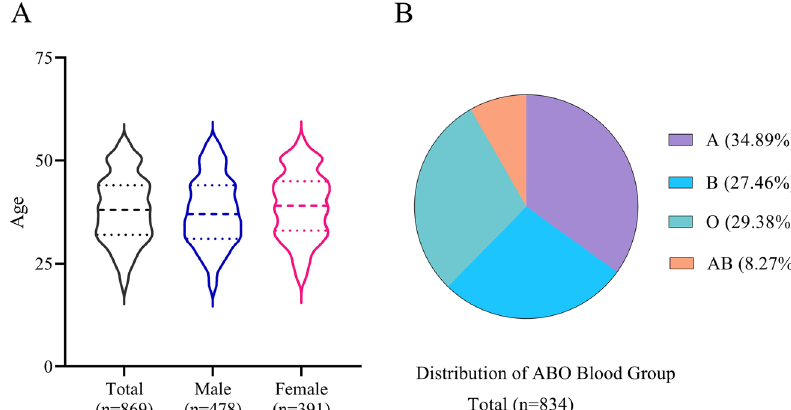
Fig. 6 Distribution of age, gender, and ABO blood group in COVID-19 convalescent plasma donors recruited in this study. ( A ) A total of 869 donors with 478 males and 371 females participated in this study. The average age of the donors was 38.21 years old (95% CI:37.67-38.75). The lines in the violin represent median and quartiles of age. ( B ) Distributions of 34.89%, 27.46%, 29.38% and 8.27% for A, B, O and AB blood groups. A, B, O, and AB are Blood